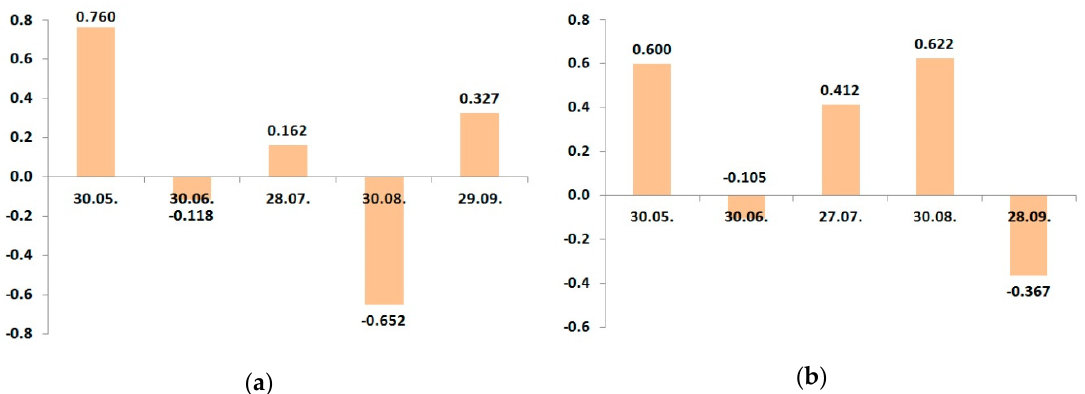
Figure 4. Dynamic changes of correlation coefficients between the potassium leaf status and yield in growing season 2017: ( a ) cv. “Zhigulevskoye”; ( b ) cv. “Lobo”.